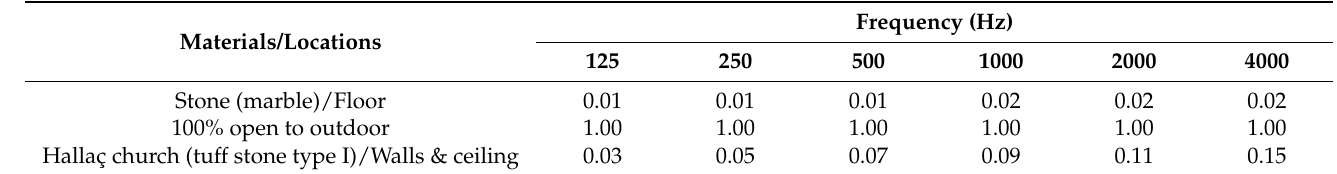
Figure 12. T30 values over 1/1 octave bands of the field test and simulated model of ( a ) the Hallaç Church; ( b ) the Avanos Dining Hall. T30 values of both the field test and the simulated model are close to each other along the frequency spectrum. Table 3. Absorption coefficients ( α ) over 1/1 octave bands of the materials applied to the Hallaç Church acoustical model.